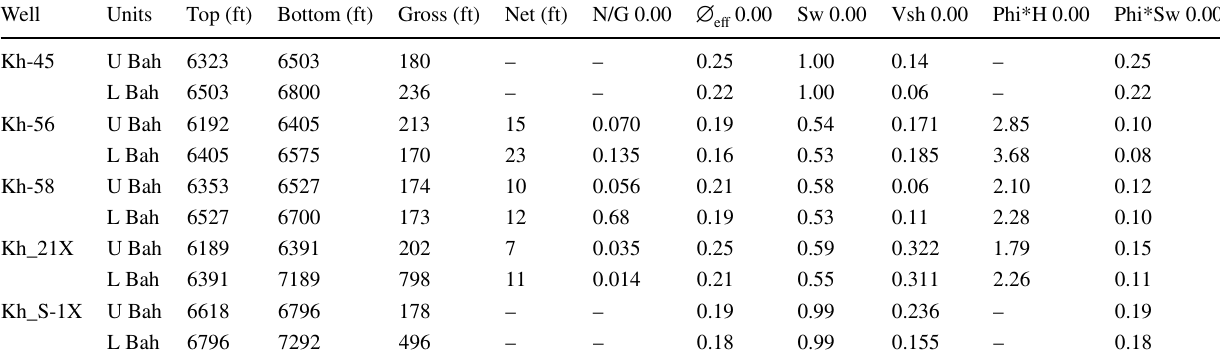
where N / G is the net to gross ratio, ∅ eff is the effective porosity, Sw is the water saturation ratios, Vsh is the shale volume, and H is the net-pay